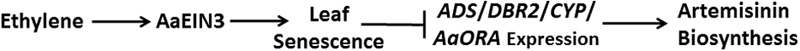
Illustration of the mechanism by which ethylene signaling negatively regulates artemisinin biosynthesis.